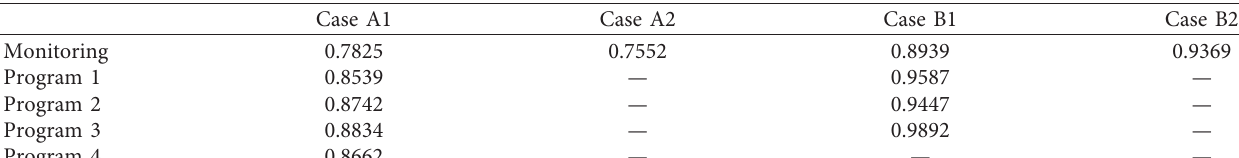
Table 11: Linear fitting correlation coefficient R 2 list.